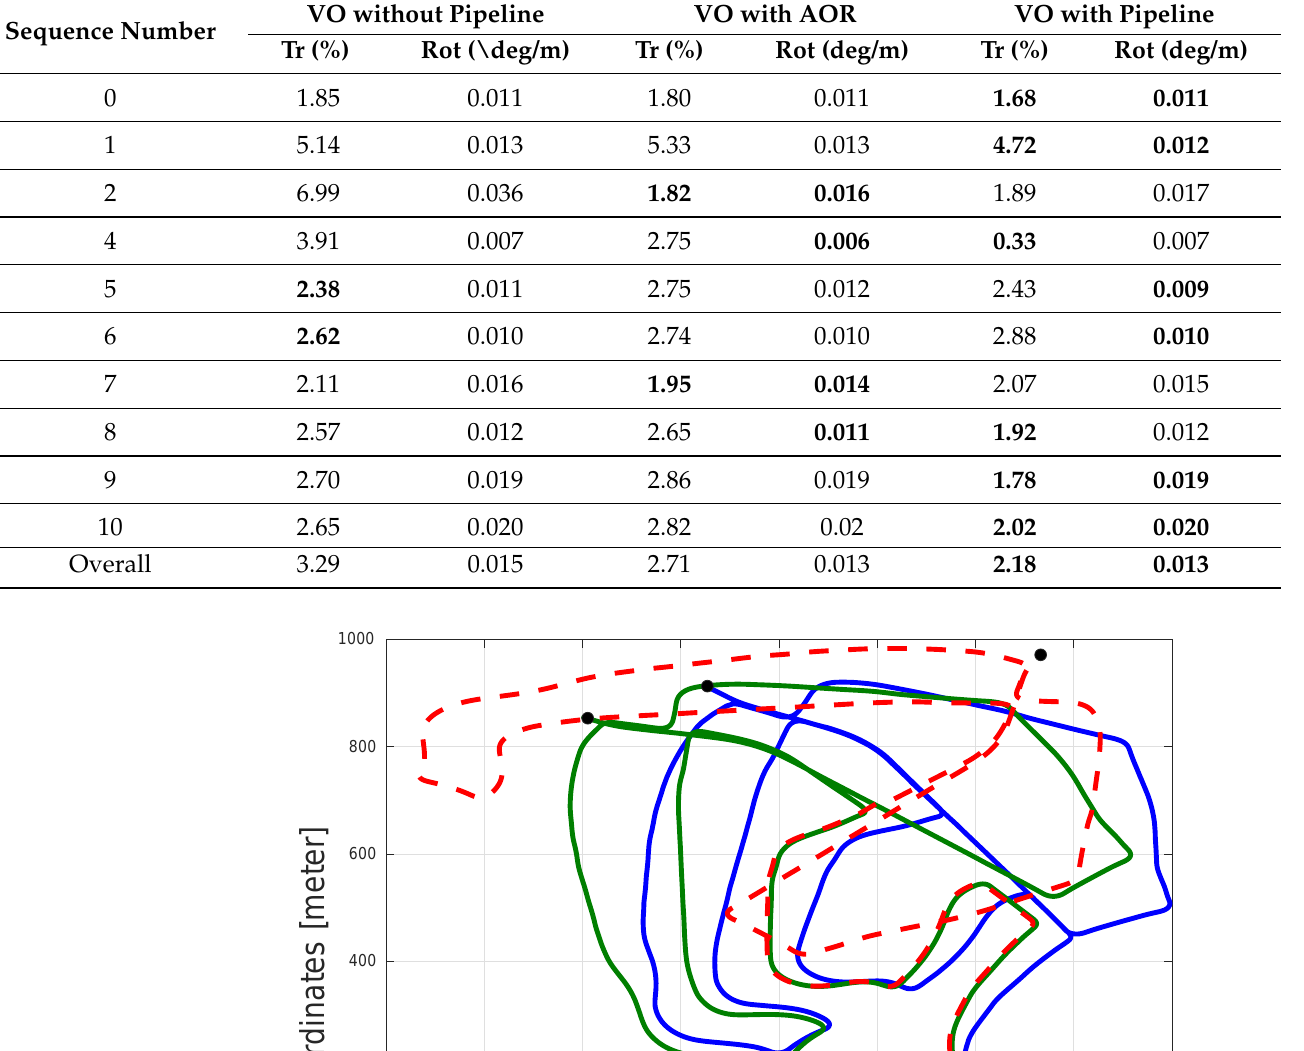
Table 1. KITTI dataset accuracy comparison.